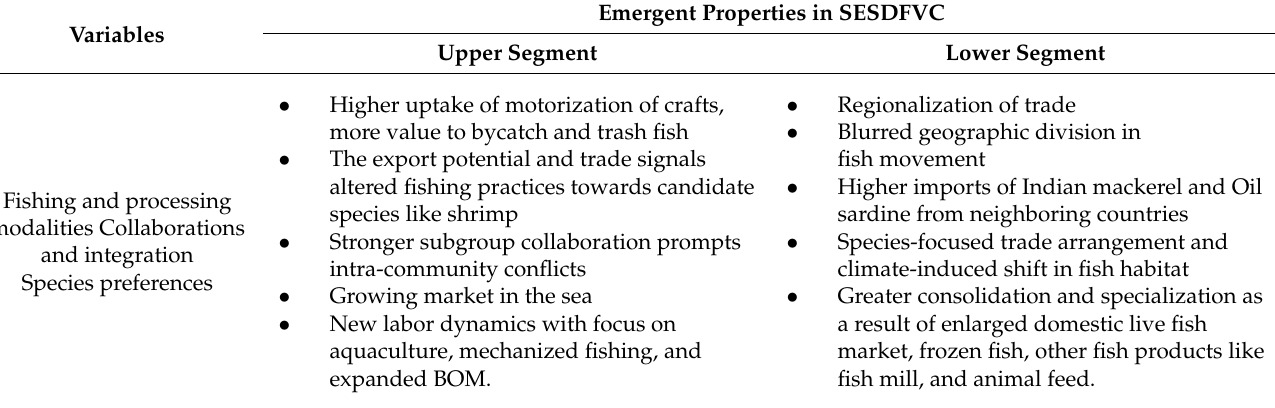
Table 7. Spatial features of emergence in